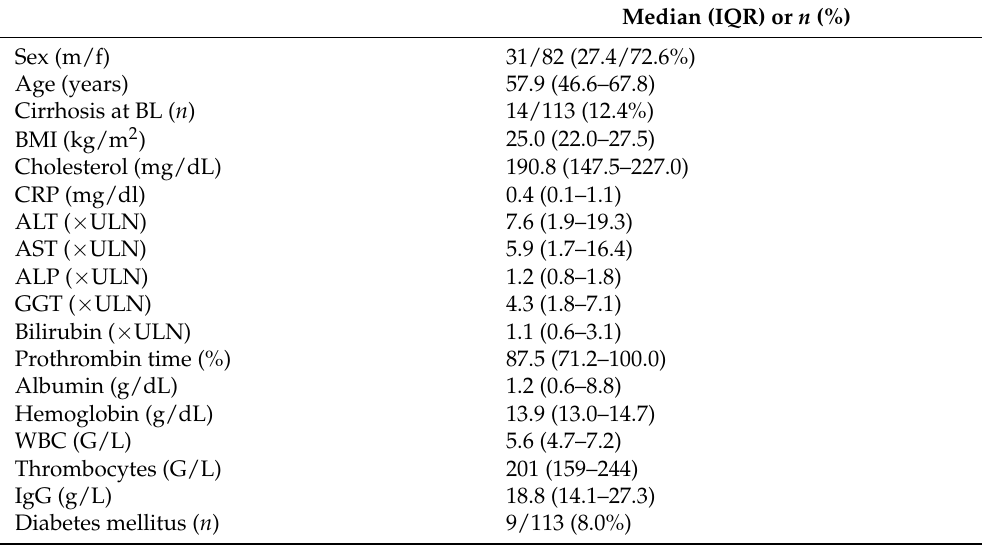
Table 1. Patient characteristics of the whole cohort at